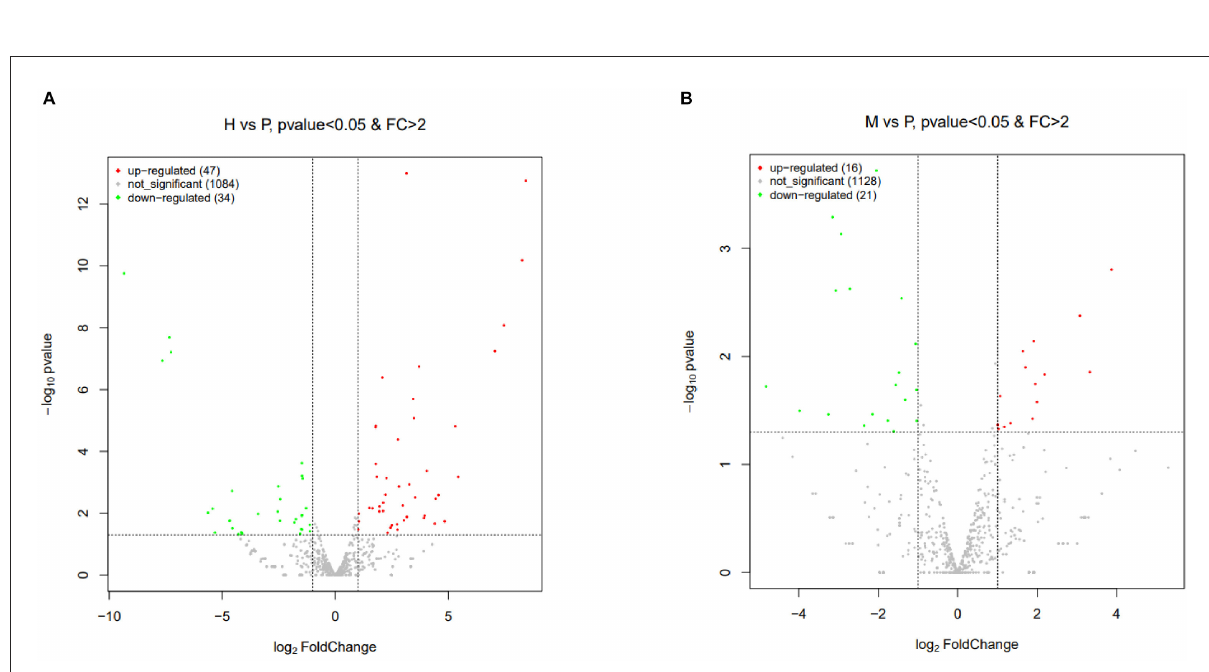
FIGURE6 Volcano plots of differentially expressed miRNAs of H vs. P and M vs. P. (A) Volcano plot of differentially expressed miRNAs between cattle (H) and cattle-yak (P). (B) Volcano plot of differentially expressed miRNAs between yak (M) and cattle-yak (P). Each point represents each DE miRNA, red represents u p- regulated and green represents